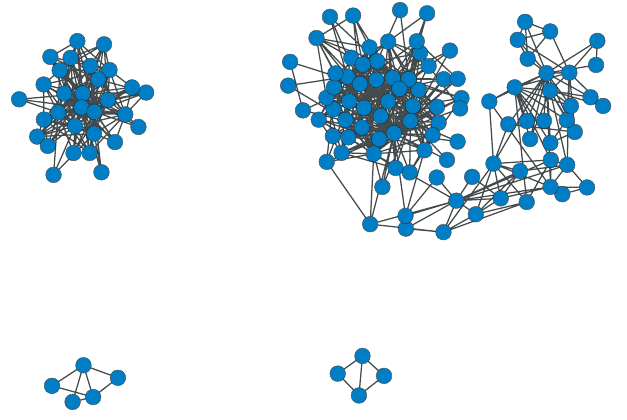
Figure 7. The network of cliques of new CCPPs not in MIPS.